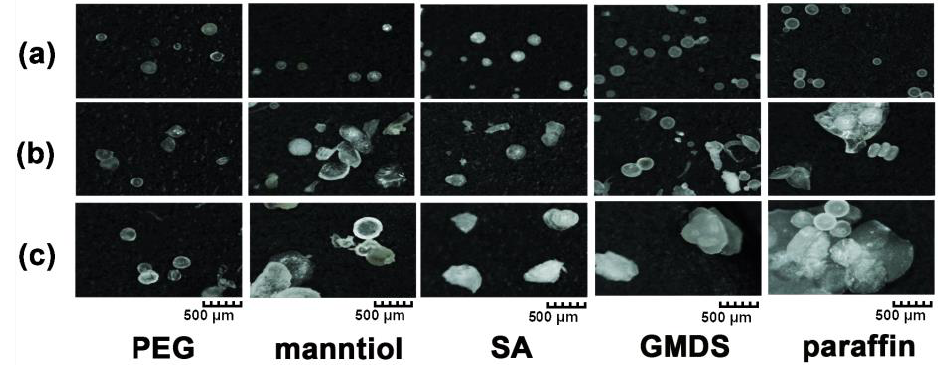
Figure 6. Influence of different operation temperatures including ( a ) T m ; ( b ) 15°C above T m and ( c ) 30 °C above T m on the morphology of products. PEG—polyethylene glycol; SA—stearic acid; GMDS—glycerol monostearate/distearate.